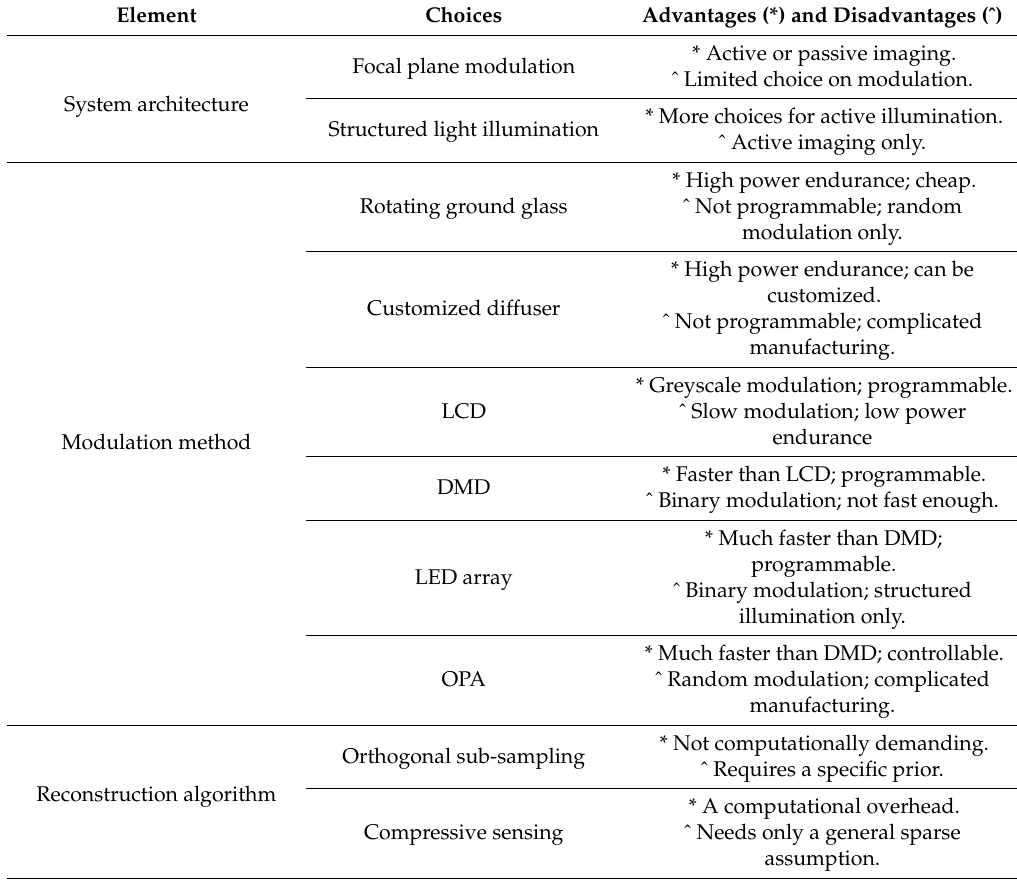
Table 1. Summary of major elements in single-pixel